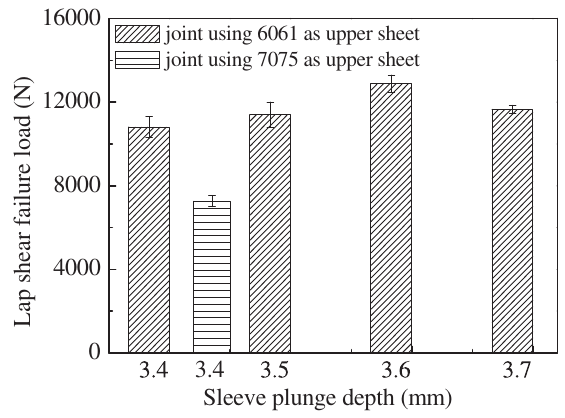
Figure 8: Lap shear failure loads of the joints.